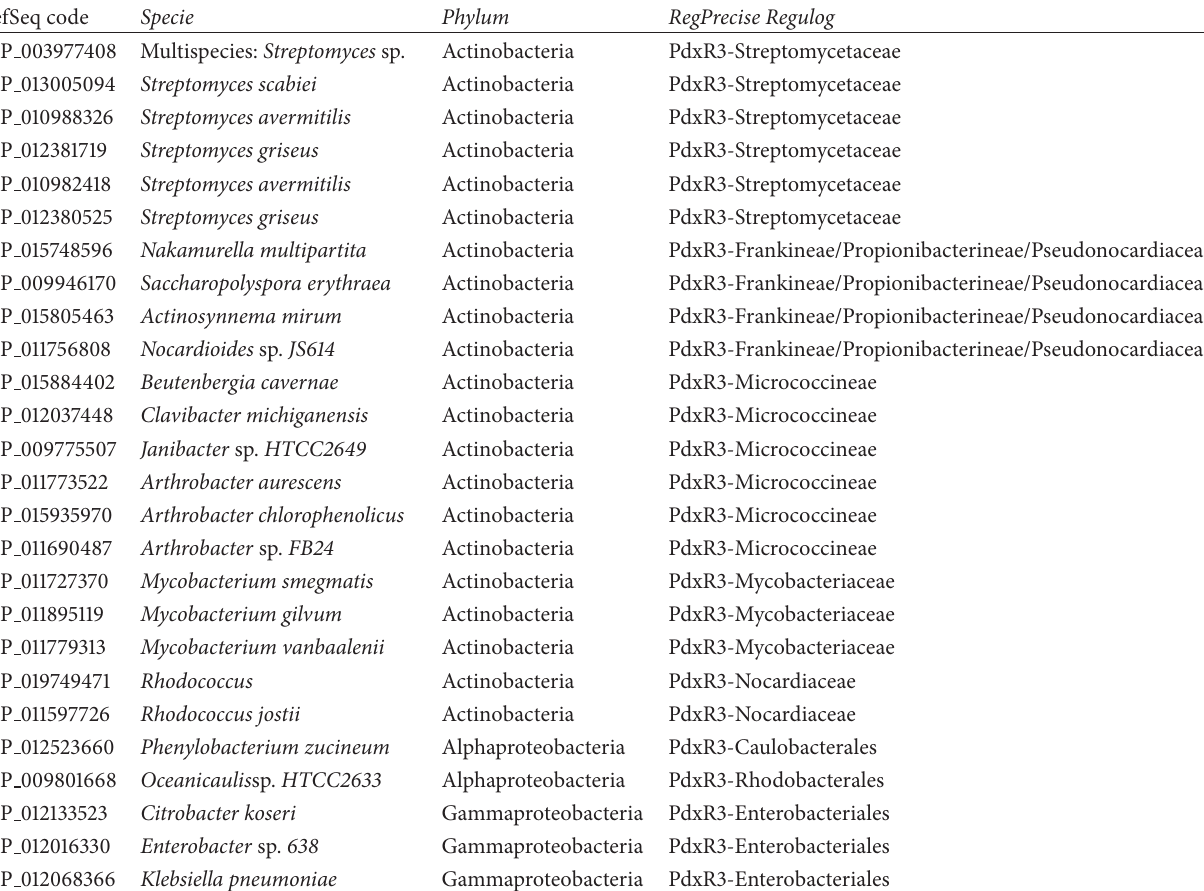
Table 1: List of MocR regulators involved in YczE-containing regulons extracted from the RegPrecise databank (YczR RegPrecise set). RefSeq